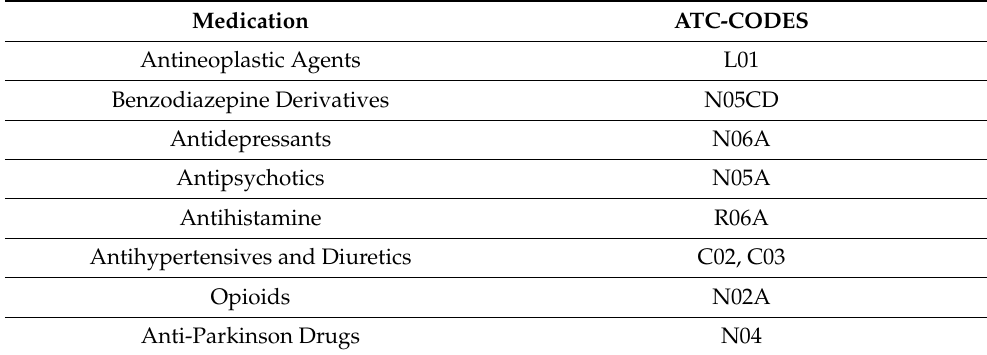
Table 2. Medication with fatigue as a possible side effect and their Anatomical Therapeutic Chemical Classification (ATC) according to the guideline ‘fatigue’ by the German Society for General Practice and Family Medicine (DEGAM)